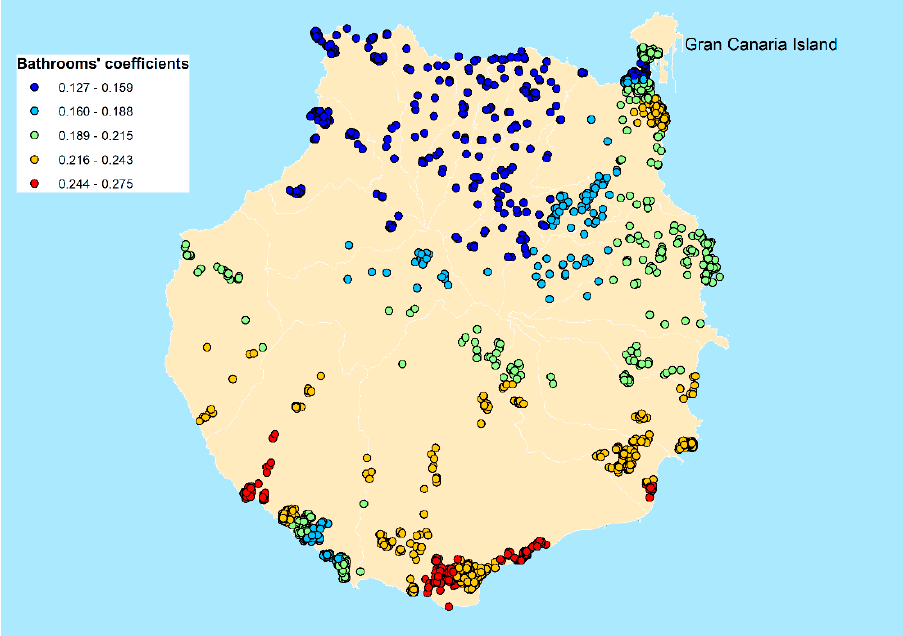
Figure 5. Distribution of the significant coefficients for the variable Bathrooms (SW-GWR model).